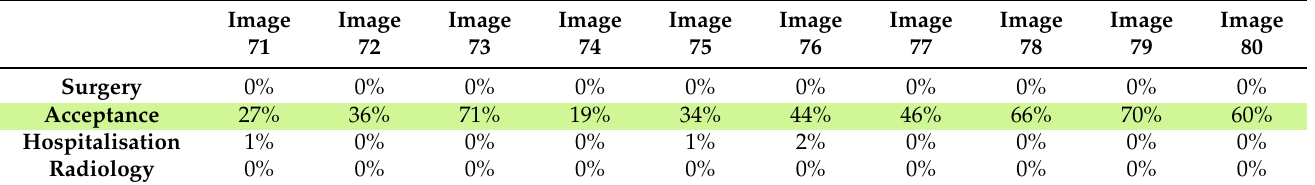
Table 13. Results obtained with the first version of the customised model for the “acceptance” IU. Each column refers to one of the test images (71 to 80) and each row shows the labels that were returned by the model. The row–column intersection shows the success rate in recognising the concept stated in the row for the image in that column.